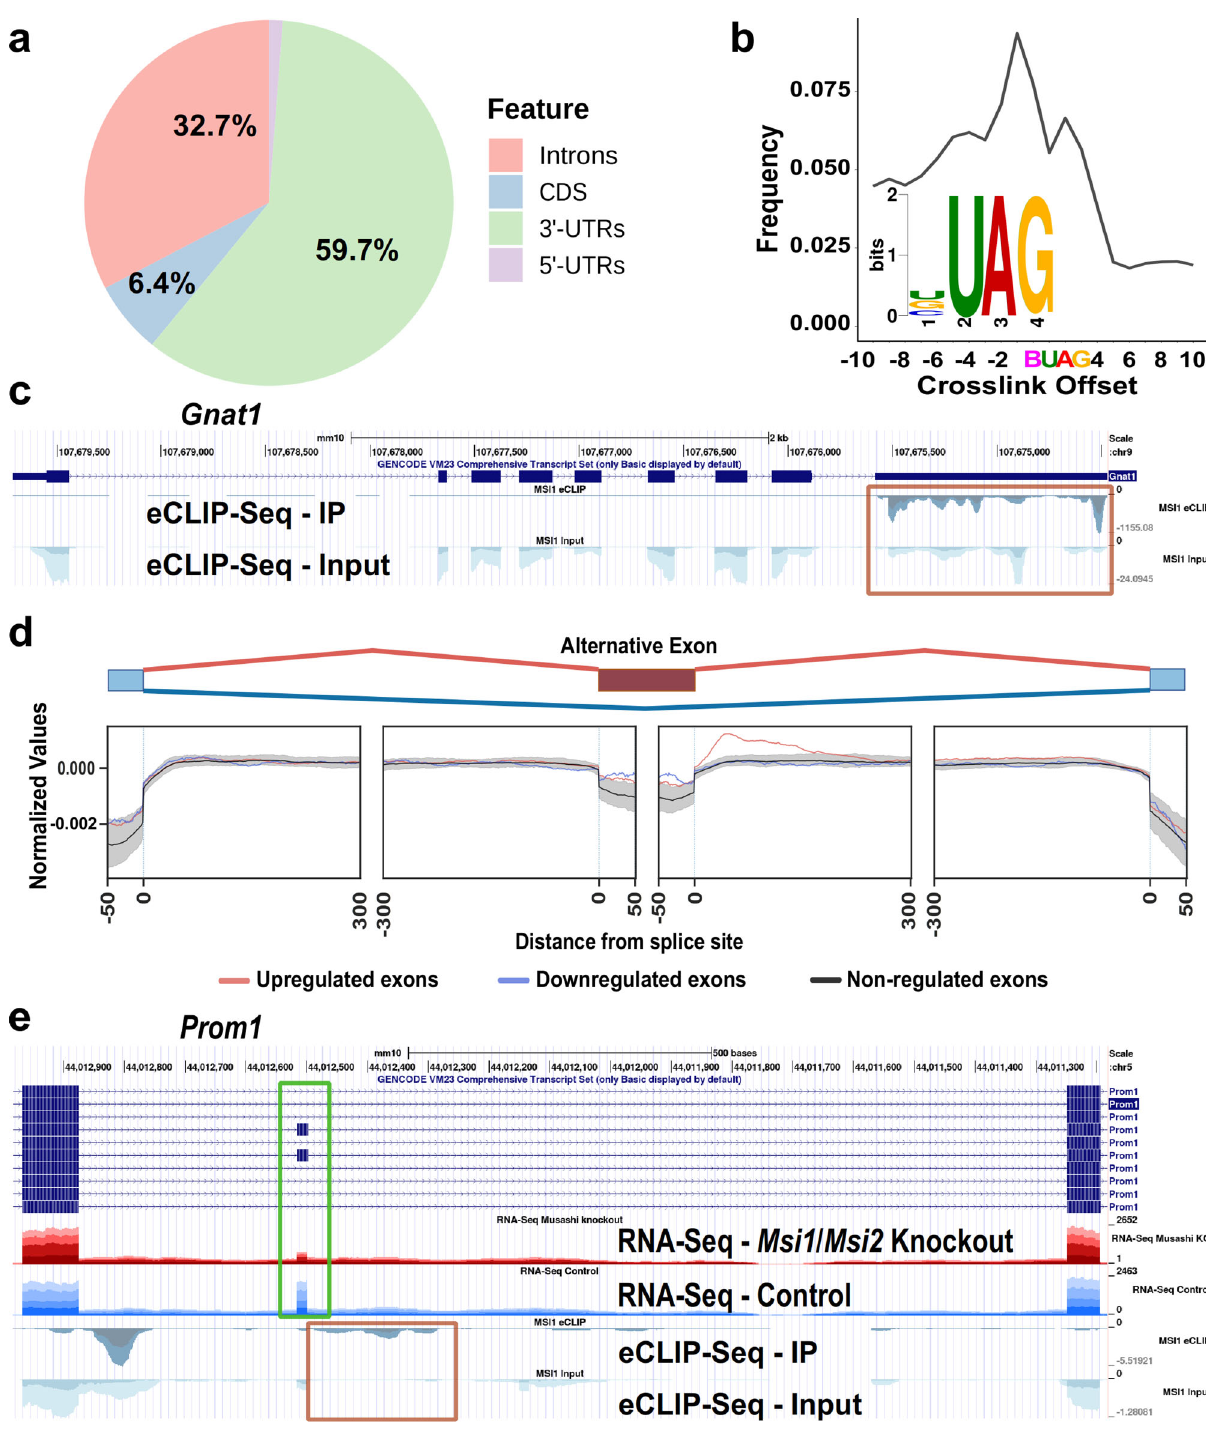
Fig. 5 In the retina MSI1 binds to UAG motifs located predominantly in introns and 3'-UTRs. a Distribution of MSI1 binding sites as identi fi ed by eCLIP- Seq on mouse retinal samples across mRNA features. b eCLIP crosslink frequency relative to the top scoring motif (BUAG) identi fi ed by DREME. c UCSC Genome browser tracks showing the eCLIP-seq signal enrichment over the 3'-UTR of the Gnat1 gene (orange box). Replicates are stacked and indicated by different shading colors. Scales are 0 to − 1155 for the eCLIP IP and 0 to − 24 for the eCLIP input. d RNA binding protein map showing MSI1 binding relative to an alternative metaexon. Exons upregulated by the Musashi proteins (downregulated in the Msi1 / Msi2 double knockout) are shown in red, exons downregulated by the Musashi proteins are shown in blue and alternative exons remaining unchanged in the knockout are shown in black. Gray shading indicates the 99.5% con fi dence interval derived from 1000 random permutations. MSI1 binding sites are enriched downstream of alternative exons upregulated by the Musashi proteins. e UCSC Genome browser tracks showing MSI1 binding (orange box) downstream of an alternative exon in the Prom1 gene regulated by the Musashi proteins (green box). RNA-Seq tracks show the read density for retinal samples derived from photoreceptor-speci fi c Msi1 / Msi2 double knockouts and matched controls. Replicates are stacked and indicated by different shading colors. Scales are 0 to − 5.5 for the eCLIP IP and 0 to − 1.3 for the eCLIP